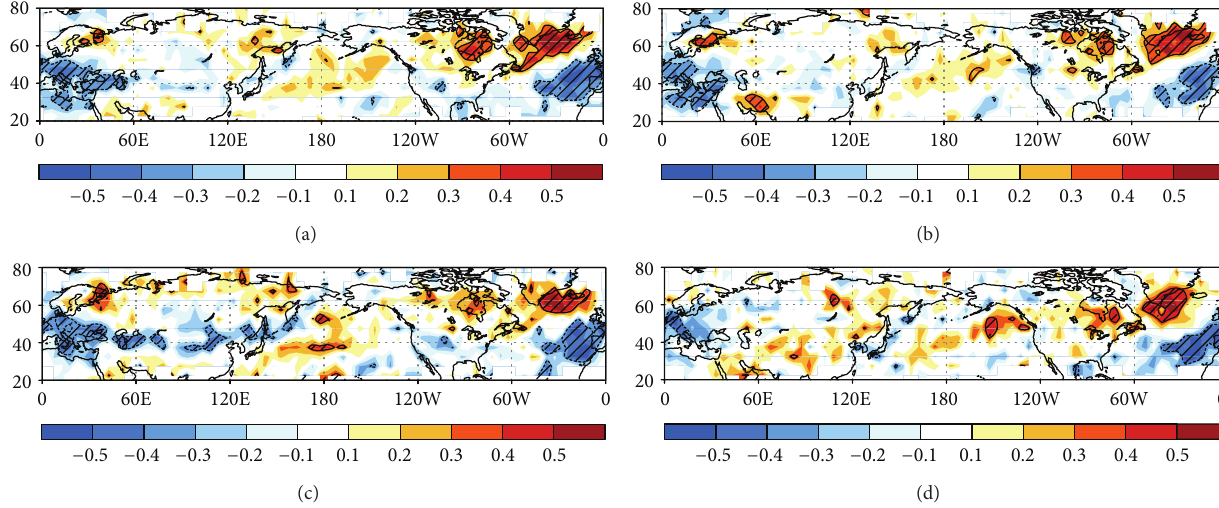
Figure 8: Correlation coefficient for JFM cyclone frequency versus NAO (excluding PNA and ENSO). Correlation (shaded) 2-tailed 95% significance (hatched) for (a) NCEP1 5801, (b) ERA40 5801, (c) NCEP1 7910, and (d) NCEP1